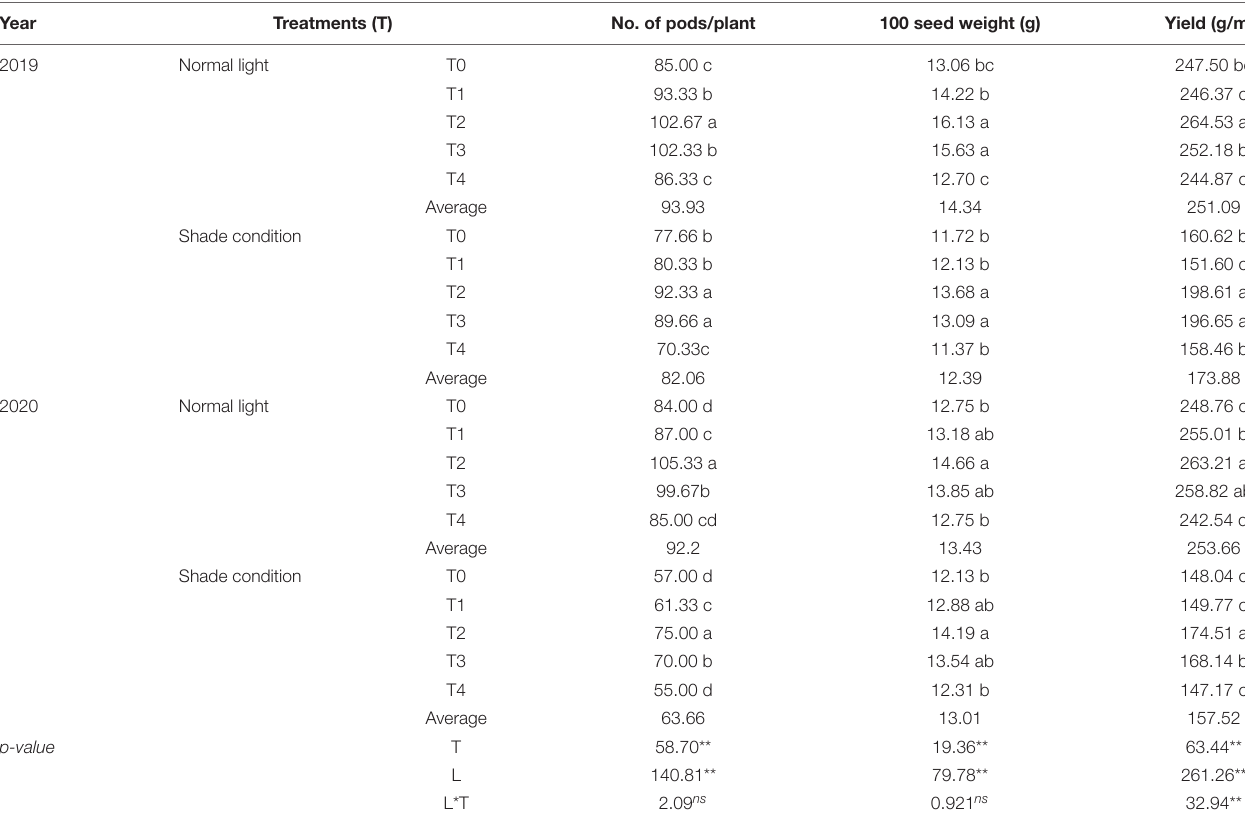
TABLE 5 | Effect of NH 4 + /NO 3 − ratios on the yield parameters under different light